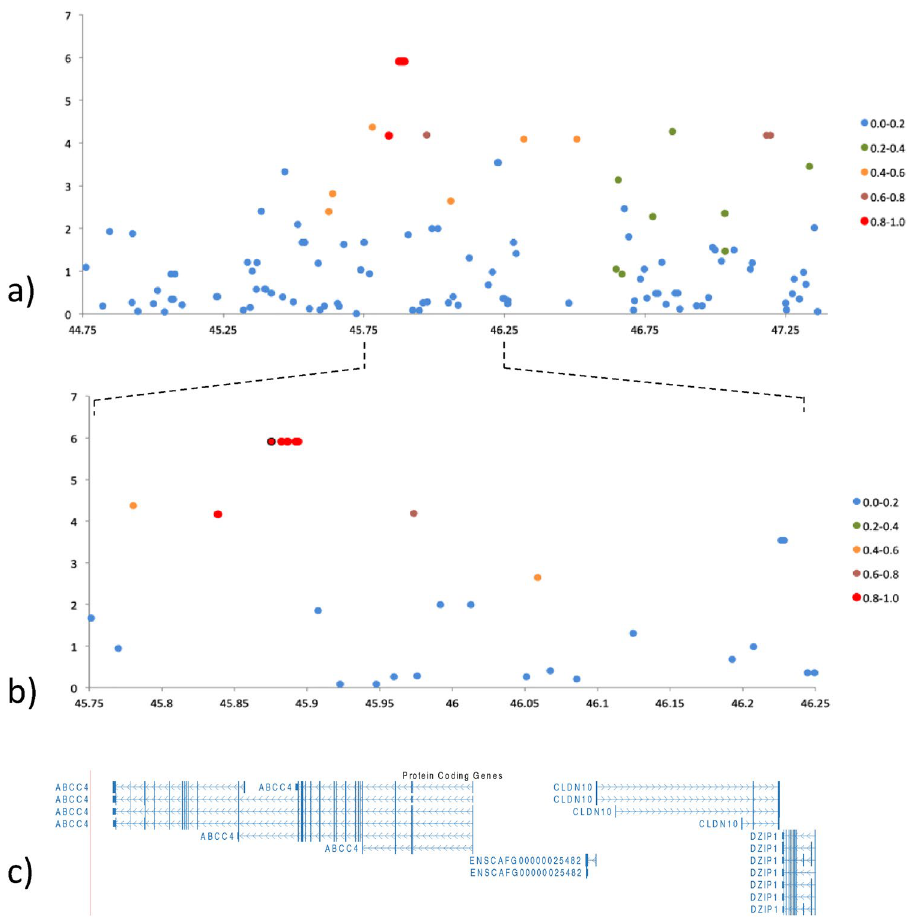
Figure 3. Detailed view of the associated locus on chromosome 22. ( a ) Zoomed in view of chromosome 22 at 44.7–47.2 Mbp. The LD R 2 -value between the most highly associated SNPs is illustrated by colour. ( b ) Further zoomed in view of the most associated SNPs on chromosome 22 cfa 45.7–46.2 Mbp. ( c ) The ABCC4 gene is located within the chromosome 22 45.7–46.2 Mbp region.